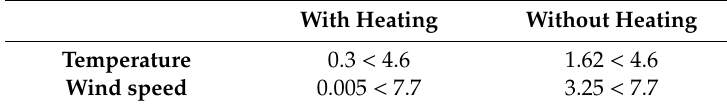
Table 6. Comparison between the F test statistic (ANOVA) and its critical value. With Heating Without Heating Temperature